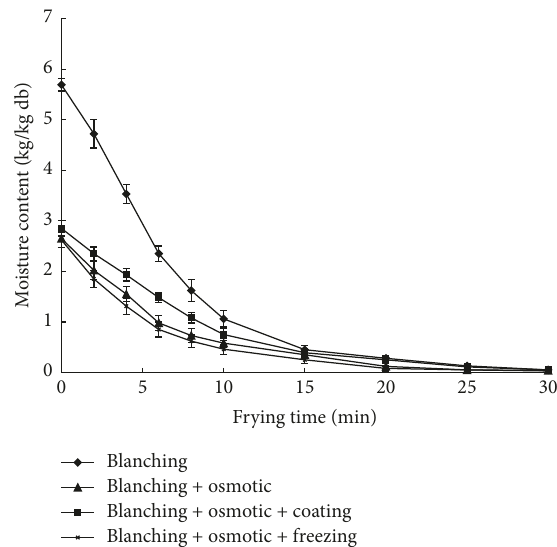
Figure 2: Effect of different pretreatments on moisture content of vacuum-fried shiitake mushroom